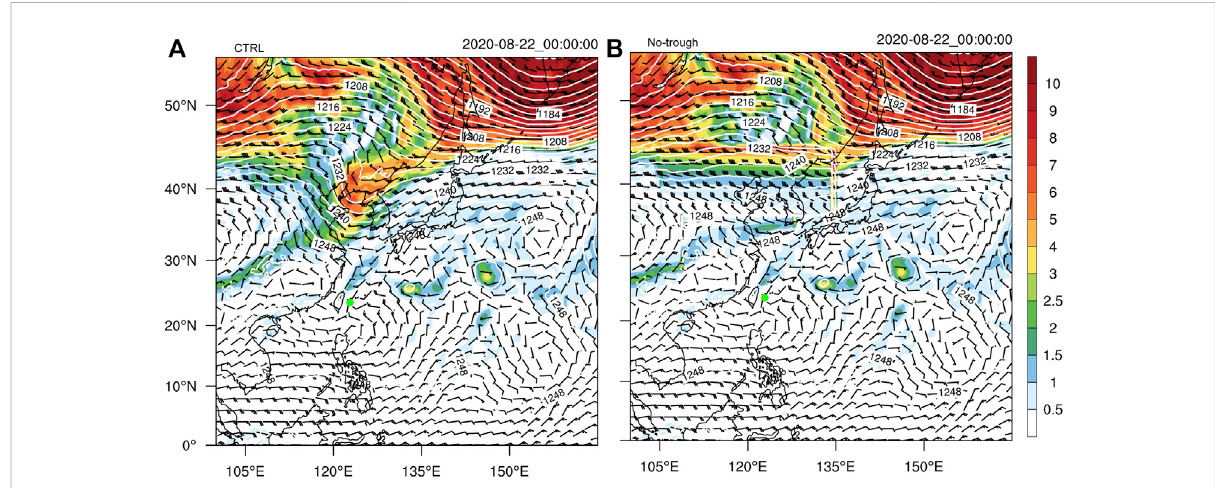
FIGURE 10 SimulatedPV(shaded,PVU),windvectors,andgeopotentialheight(contour,m)at200 hPaattheinitialtimeof0000UTC22AugustinCTRL (A) and No-trough (B) ,